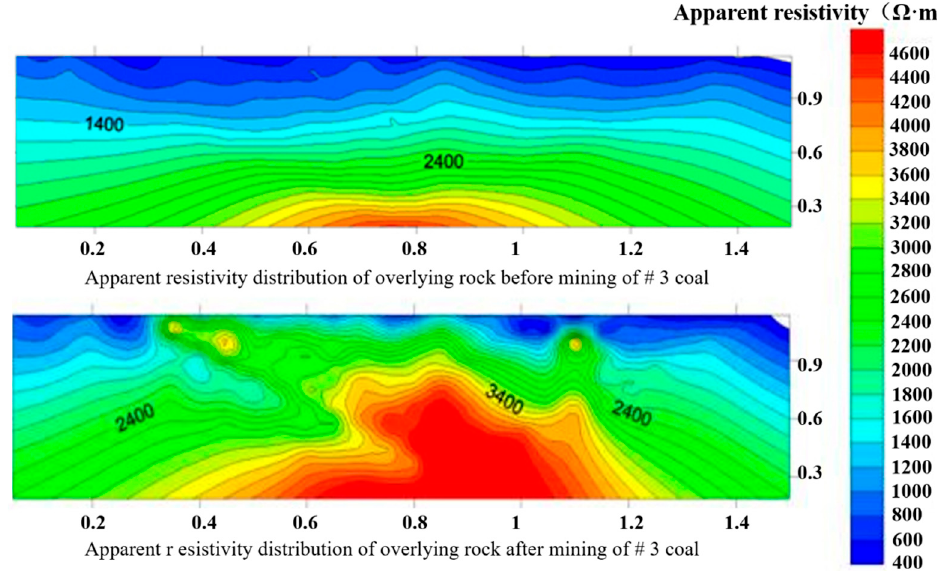
Figure 6. Comparison diagram of apparent resistivity distribution of overlying rock before and after mining of # 3 coal.